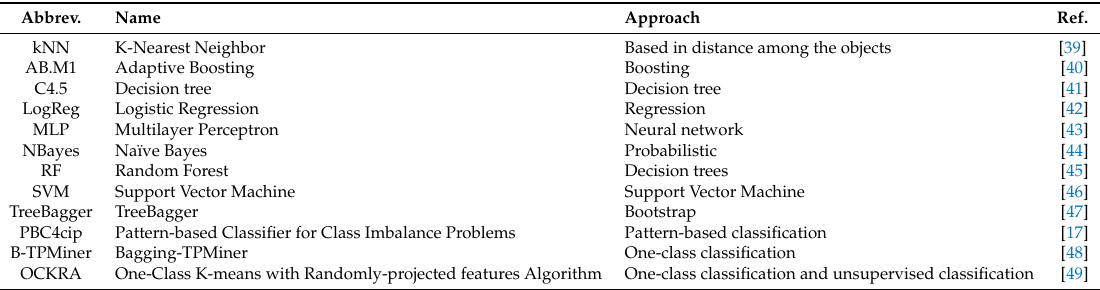
Table 3. Supervised classifiers selected in this paper for testing the performance in the detection of a pneumatic failure in a